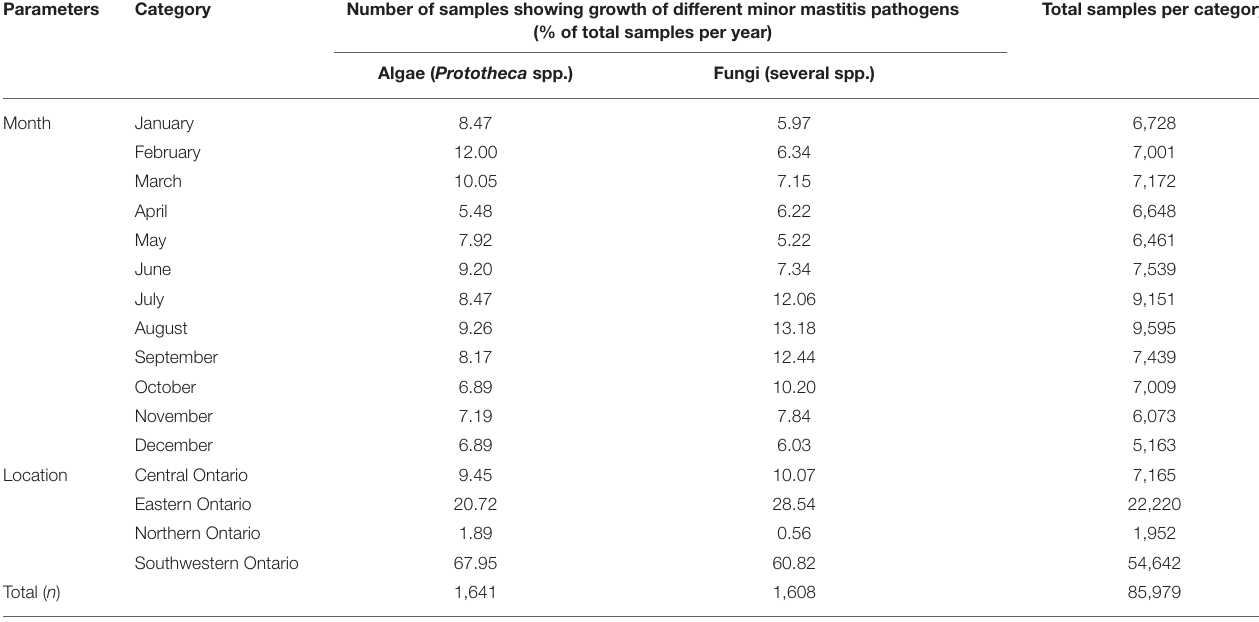
TABLE 5 | Temporal (monthly) and spatial change in the proportion of samples positive for algae and fungi in bovine milk samples between 2008 and 2017 in Ontario, Canada. Parameters